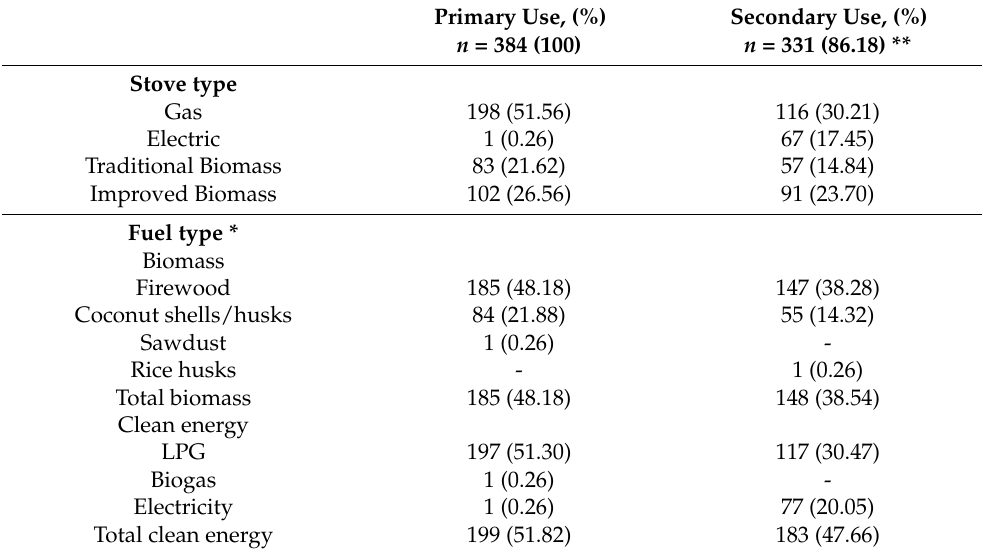
Table 2. Primary and secondary cooking fuels and stove types used during pregnancy by 385 mothers in Central Sri